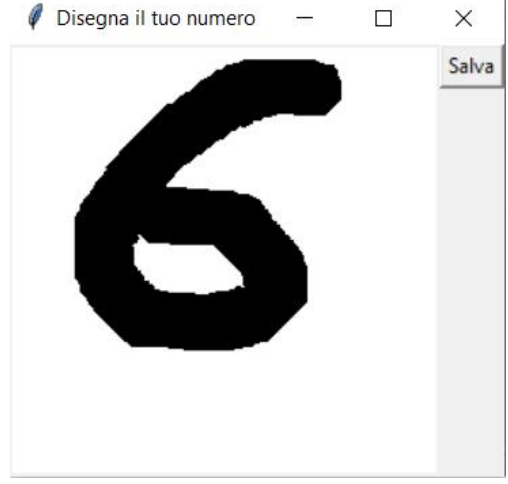
Figure 7. Digit “6” drawn by the user.